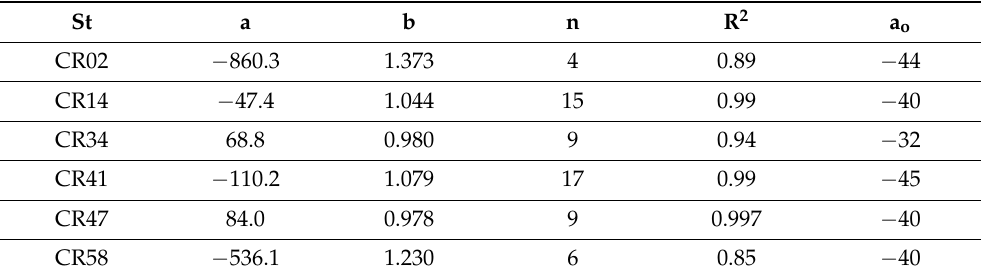
Table 2. Empirical parameters of linear dependences DIC vs. TA: a—intercept; b—slope; n—number measurements; R 2 —the coefficient of determination and parameter of interstitial waters; and a o (a o = DIC o − TA o ); where DIC o and TA o are DIC and TA in supernatant waters. St a b n R 2 a o CR02 − 860.3 1.373 4 0.89 − 44 CR14 − 47.4 1.044 15 0.99 − 40 CR34 68.8 0.980 9 0.94 − 32 CR41 − 110.2 1.079 17 0.99 − 45 CR47 84.0 0.978 9 0.997 − 40 CR58 − 536.1 1.230 6 0.85 −